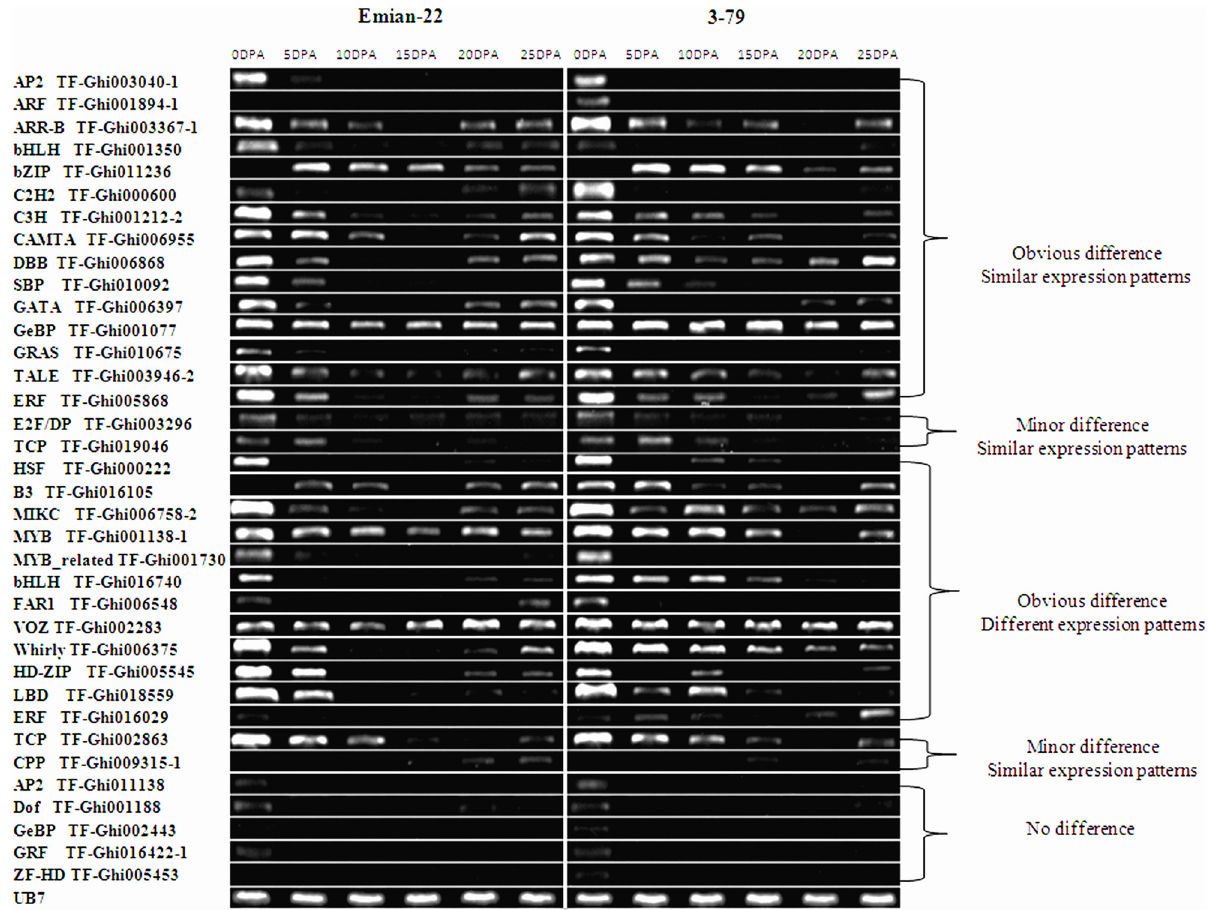
Fig 4. RT-PCR analysis of TFs between mapping parents. The numbers on the top represent fibers at 0 DPA, 5 DPA, 10 DPA, 15 DPA, 20 DPA, and 25 DPA for Emian22 and 3 – 79. Similar expression trends between Emian22 and 3 – 79 were classified as similar expression patterns. Apparent differences in expression between Emian22 and 3 – 79 were classified as different expression patterns. Obvious differences in expression levels between Emian22 and 3 – 79 were classified as obvious differences. Minor or no differences in expression levels between Emian22 and 3 – 79 were classified as no difference. Gene primers and their family names are indicated on the